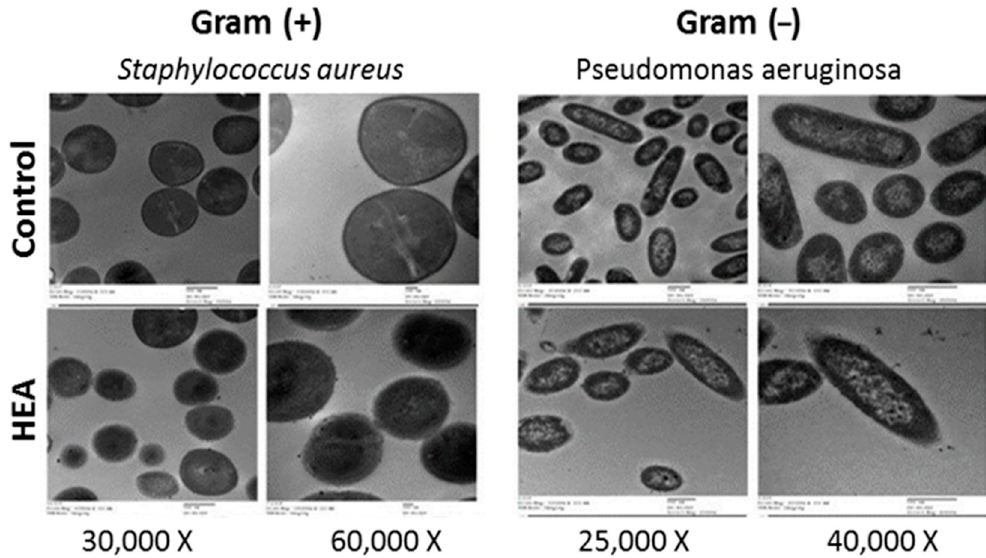
Figure 5. Transmission electron microscopic graphs Staphylococcus aureus and Pseudomonas aeruginosa as subjected to 100 and 150 µ g / mL of hydrolyzed egg albumin, respectively.